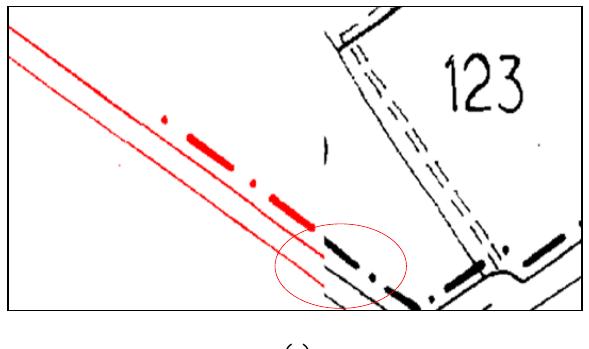
Figure 8. The residuals of points in the first test.